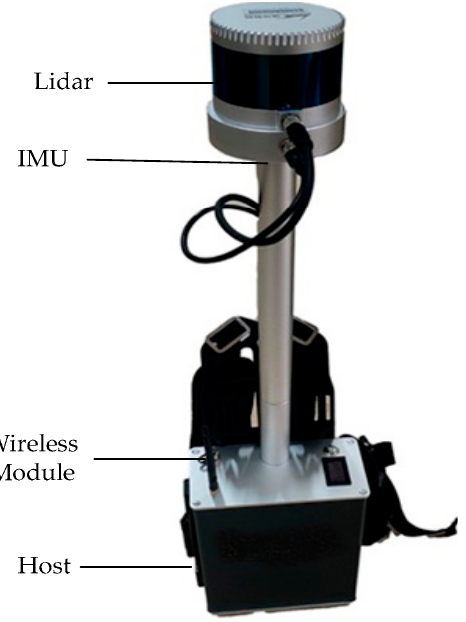
Figure 21. The experimental equipment. It is a backpack system integrating LiDAR, an inertial measurement unit (IMU), a wireless module, and an upper computer.